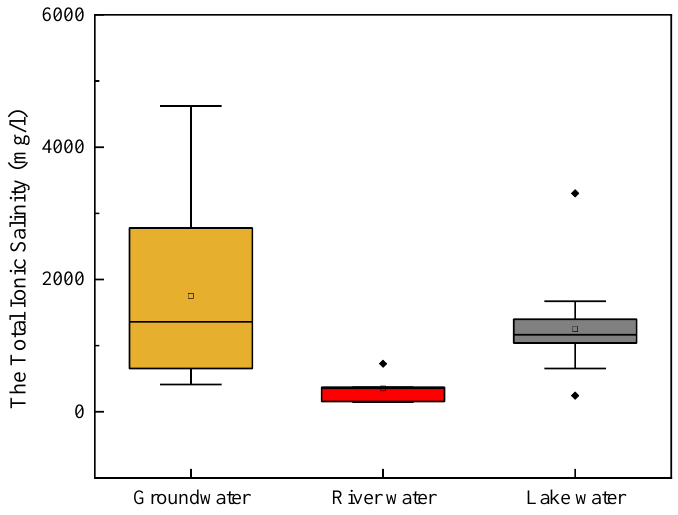
Figure 2. The concentration of total ionic salinity of the water in the Hulun Lake regime.